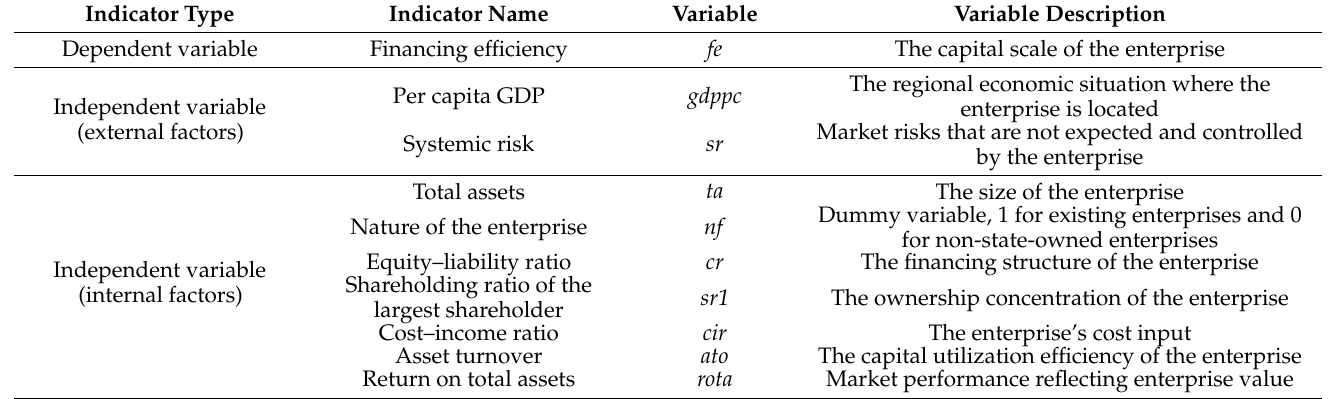
Table 2. Selection results of influencing